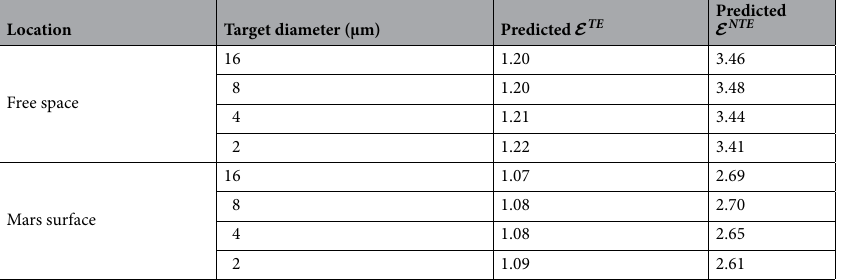
TE NTE Table 4. Predicted E and E metrics for the space environment and for the Mars surface: predictions are based on published calculated lineal energy distributions for the space environment and for the Mars surface (from Northum et al. 55 ), combined with our best-fit q ɛ ( y ) functions for TE and NTE. Details of the methods are described in the